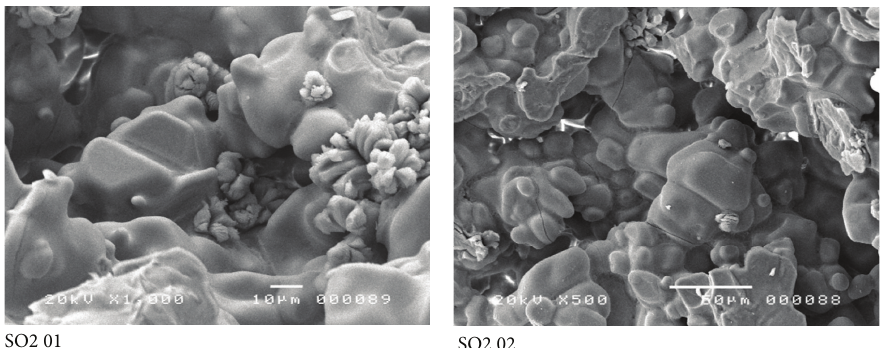
Figure 9: SEM observations show crystals during formation: diagenesis of white clinker